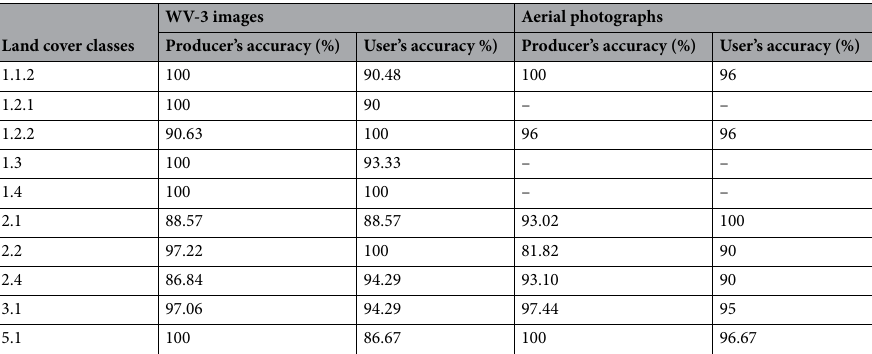
Table 4. Classification accuracies for the Aksu region.